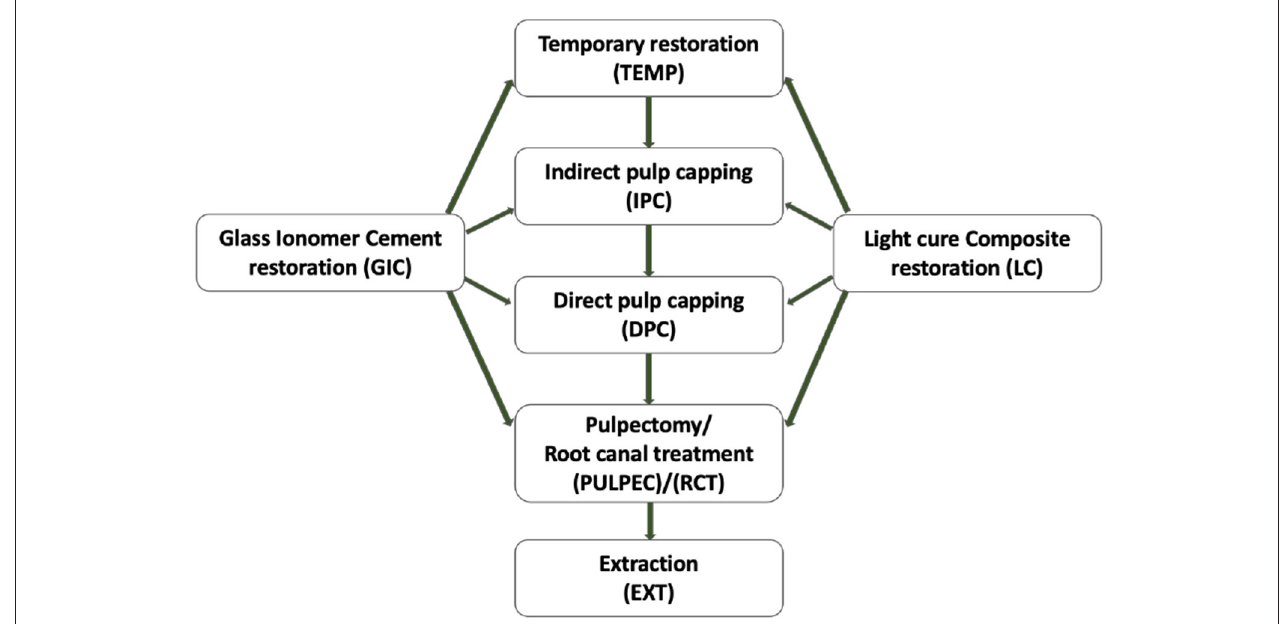
FIGURE 1 | Progression of Treatment Needs. The progression of dental caries as shift in treatment needs: 10% temporary restoration progressed to IPC; 10% IPC progressed to DPC; 10% DPC to PULPEC and RCT. 10% GIC and LC progressed to temporary restorations; 10% of which moved to IPC followed by DPC and further followed by PULPEC and RCT. Ten percent of PULPEC and RCT shifted to deciduous and permanent teeth extractions respectively.